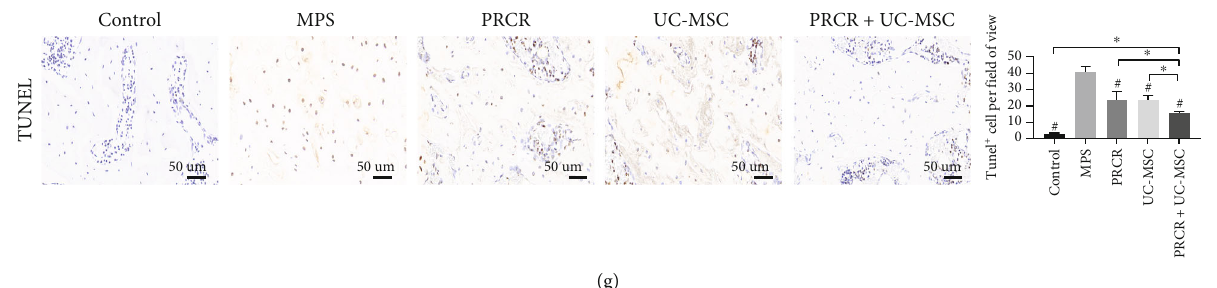
Figure 6: E ff ects of PRCR, UC-MSCs, and PRCR + UC-MSCs on bone tissue protection and necrosis restoration in the ONFH rat model. (a) Visualized intra-articular injection using ultrasonic guidance, the white arrows indicated the needle pathway. (b, c) Representative micro- CT images of femoral heads (coronal, transverse, and sagittal images) from di ff erent treatment groups followed by quantitative analysis. The PRCR, UC-MSC, and PRCR + UC-MSC treatments improved the microstructural parameters changes and bone loss compared to the MPS group ( P < 0 : 05 ). (d) Hematoxylin and Eosin (HE) staining of femoral heads from di ff erent groups. (e) Immunohistochemical staining of RUNX2, ALP, and VEGF of di ff erent groups followed by quantitative analysis. The treatment groups signi fi cantly promoted the expression of RUNX2, ALP, and VEGF compared to the MPS group ( P < 0 : 05 ). (f) Representative tartrate-resistant acid phosphatase (TRAP) staining images showing the distributions of osteoclasts in the femoral heads from di ff erent groups, followed by quantitative analysis. The black arrows indicate the osteoclasts. The number of TRAP-positive cells in the treatment groups was signi fi cantly lower compared to the MPS group ( P < 0 : 05 ). (g) Representative TUNEL staining images of femoral heads from di ff erent groups, followed by quantitative analysis. The apoptotic cell numbers in the treatment groups were signi fi cantly decreased compared to the MPS group ( P < 0 : 05 ) ( n = 5 for each group. # Comparisons between the DEX group and other groups, P < 0 : 05 ; ∗ Comparisons between the two groups, P < 0 : 05 ). Tb.Th: trabecular thickness; Tb.Sp: trabecular separation; BV/TV: bone volume per tissue volume; Tb.N: trabecular number; PRCR: platelet-rich plasma clot releasate; UC-MSCs: umbilical cord mesenchymal stem cells; DEX: dexamethasone; TUNEL: terminal deoxynucleotidyl transferase-mediated deoxyuridine triphosphate (dUTP) nick-end labeling; VEGF: vascular endothelial growth factor; ALP: alkaline phosphatase; MPS: